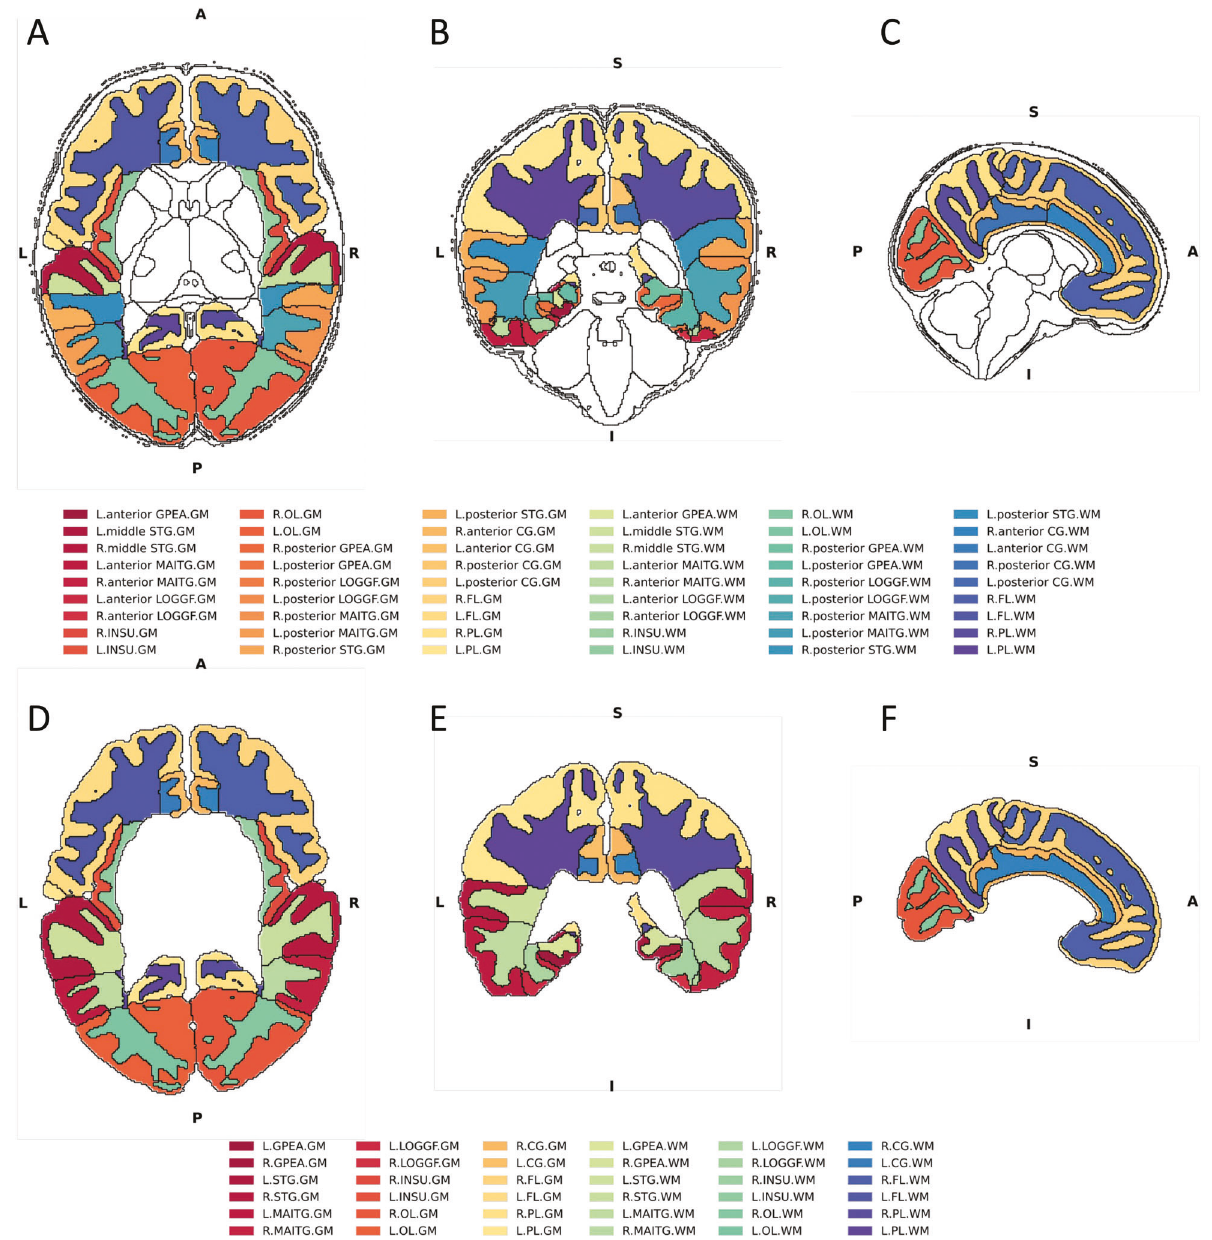
Fig. 1 DrawEM neonatal brain segmentation. Visualisation of the brain regions examined in axial ( A , D ), coronal ( B , E ) and sagittal views ( C , F ). A – C — Black outline denotes segmented brain regions, where cortical white and grey matter regions and their subregions examined in this study are coloured. D – F Cortical white and grey matter regions examined in this study after summing up their respective subregions. GPEA gyri paraphippocampalis et ambiens, STG superior temporal gyrus, MAITG medial and inferior temporal gyrus, LOGGF lateral occipotemporal gyri, gyrus fusiform, CG cingulate gyrus, FL frontal lobe, PL parietal lobe, OL Occipital lobe, INSU Insula. Not shown anterior temporal lobe. L left side of the brain, R Right side of the brain. WM white matter, GM grey matter. A Anterior, P Posterior, S Superior, I Inferior, L Left, R